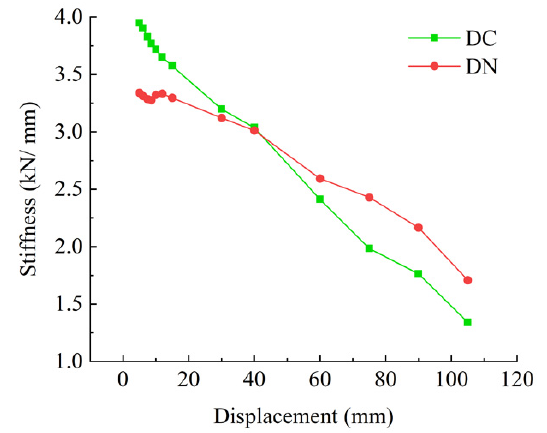
Figure 15. Degradation of stiffness of DC and DN.